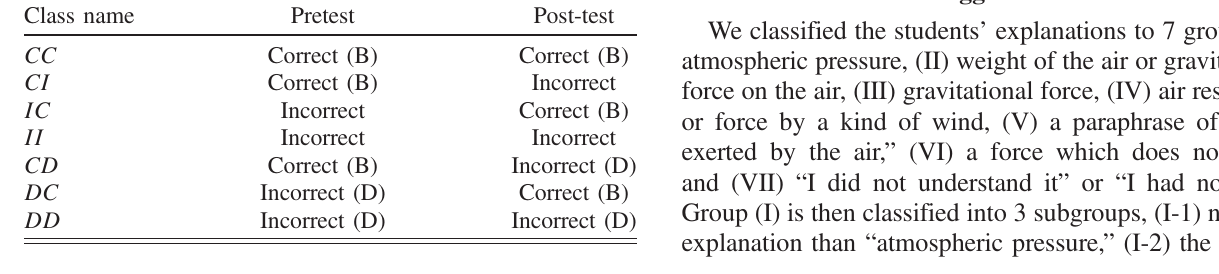
TABLE IV. Change of students ’ responses to Q.29 from the pretest to the post-test in three classes with systematic loss. The confidence interval was written as the superscript and subscript numbers, respectively. N is the number of students. Physics class h S 30 i Rate of response pairs (%) to